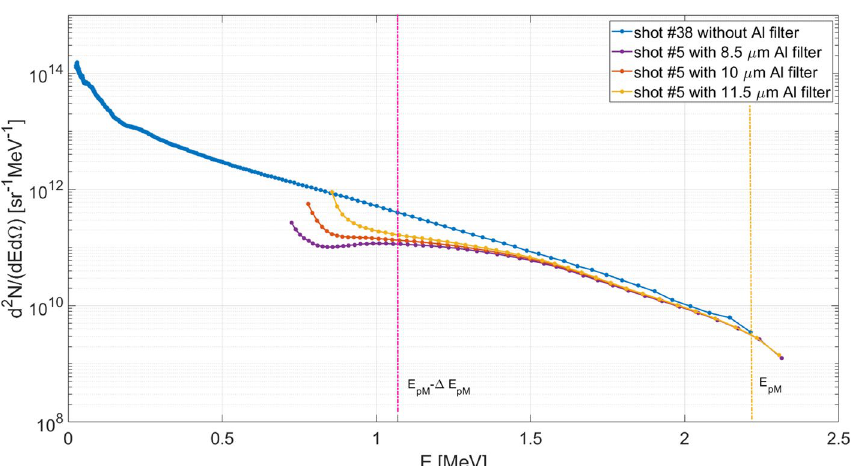
Figure 5. Comparison between the spectra obtained from the signals acquired for the shot #38, without the Al filter, and shot #5 with the Al filter for the three thicknesses, according to the nominal tolerances. The vertical yellow line indicates the maximum proton energy ( E pM ) obtained during shot #38 and the magenta line corresponds to the energy where the ion contribution to that spectrum ends (namely E pM described in the section “Estimation of the energy range for pure proton